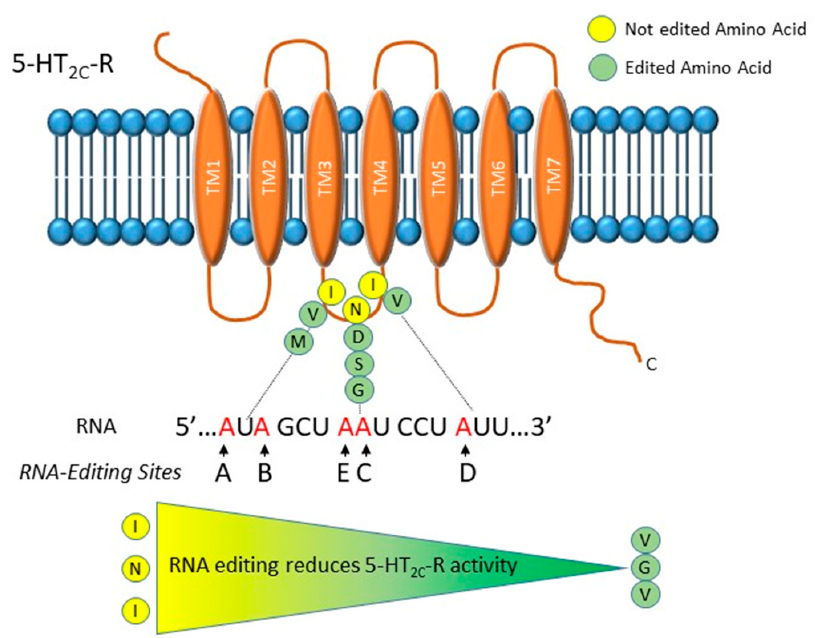
Figure 1. Graphical representation of the serotonin 2C receptor (5-HT2c) receptor and its editing sites. The five editing sites, named A, B, C, D and E, are mapped in the RNA sequence that encodes for the second intracellular loop of the receptor. At the protein level, they induce one to three amino acids changes that can result in twenty-four different protein isoforms with different G-protein-coupling activity. In particular, it has been reported that the edited isoforms have a decreased G-protein- coupling activity and in turn a lower serotonin affinity. Thanks to its ability of modulating serotonin signaling, dysregulation in 5-HT2c receptor RNA editing might be involved in the etiology of major depressive disorder